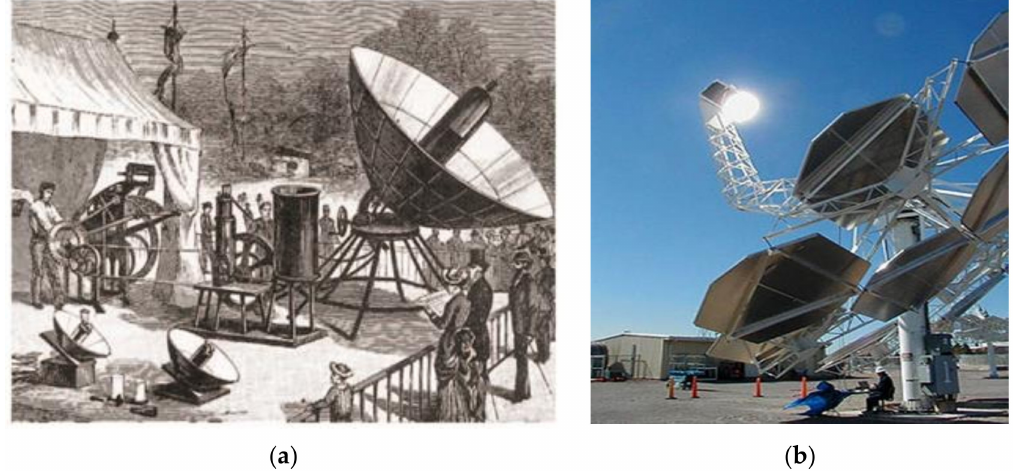
Figure 4. Solar parabolic collector [43,46]. ( a ) First concept; ( b ) Modern